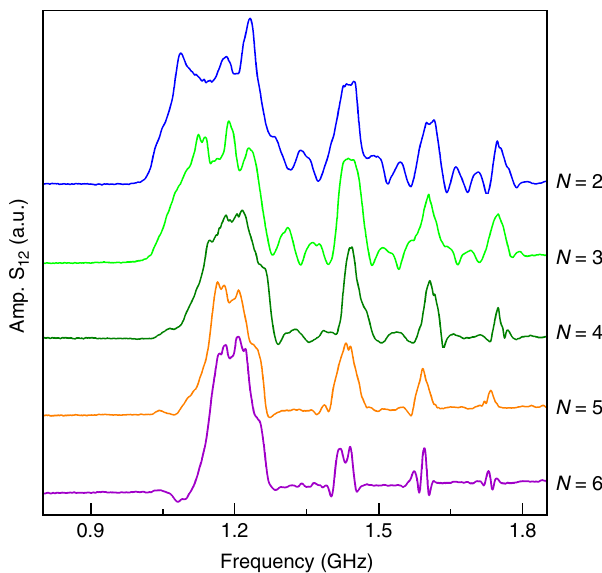
Fig. 5 Dependence of spin-wave transmission spectra on the number of grooves. Transmission spectra of CoFeB/YIG bicomponent magnonic crystals with w = 2.5 μ m, a = 30 μ m, and different numbers of CoFeB- fi lled grooves ( N ). For clarity, the spectra are plotted with constant